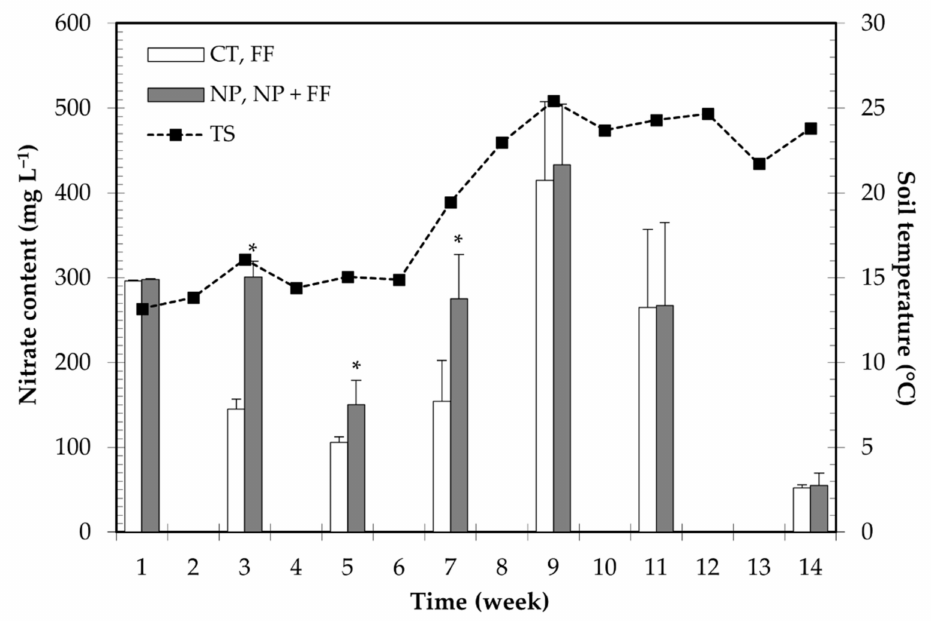
Figure 1. Nitrate content changes in the soil during the growing season due to nitrapyrin treatment and soil temperature. Each column represents the means ± SD (n = 6) of nitrate measurements. Data of the dashed line show the weekly mean of average daily soil temperature. CT: untreated control; FF: foliar fertilizer; NP: nitrapyrin-treated soil; NP + FF: joint treatment of nitrapyrin and foliar fertilizer; TS: soil temperature; Asterisks (*) indicate significant differences (Student’s t -test, p < 0.05) between nitrapyrin-treated and untreated